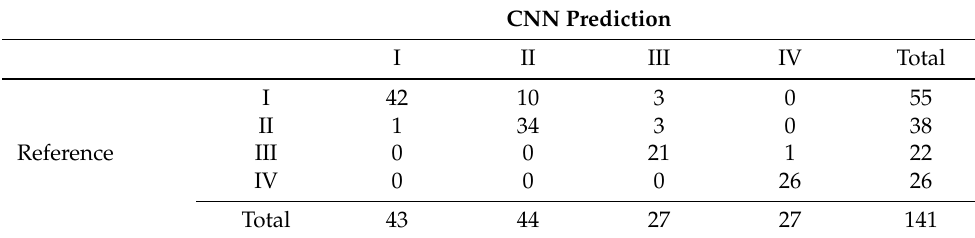
Figure 6. Left : Regression plot of reference vs predicted TAC score values for patients ( y = 1.0 x + 17, r 2 = 0.996, n = 141). Right : Mountain plot (also called folded empirical cumulative distribution plot) showing differences between predicted and reference TAC score values by patient percentile. Red points indicate patients with TAC score differences > 200. TAC predictions were calculated from the BRC network that took into account the position of the lesions within the thoracic aorta segments. BRC: Best Regional Combination network Table 4. Reclassification confusion matrix for the median BRC CNN. Among the 141 patients, the classifier assigned the 87% to the correct category. An overestimation by one CVD risk category occurred in 11% of the patients and only 2% had their risk overestimated by two CVD risk categories. Conversely, a single patient has been underestimated by only by 1